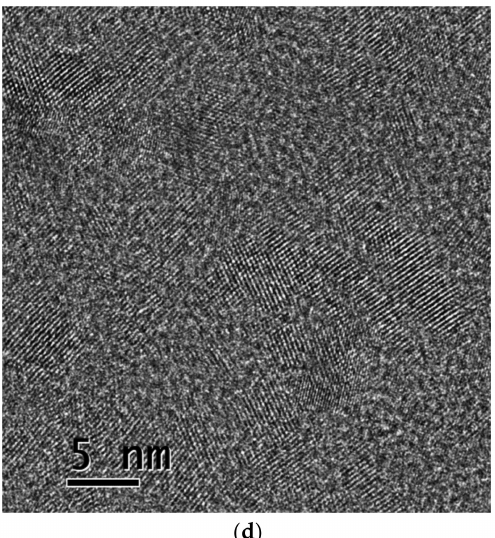
Figure 4. HRTEM images of dialysis products synthesized in EDA: ( a , b ) CDs and ( c , d ) dialysate.